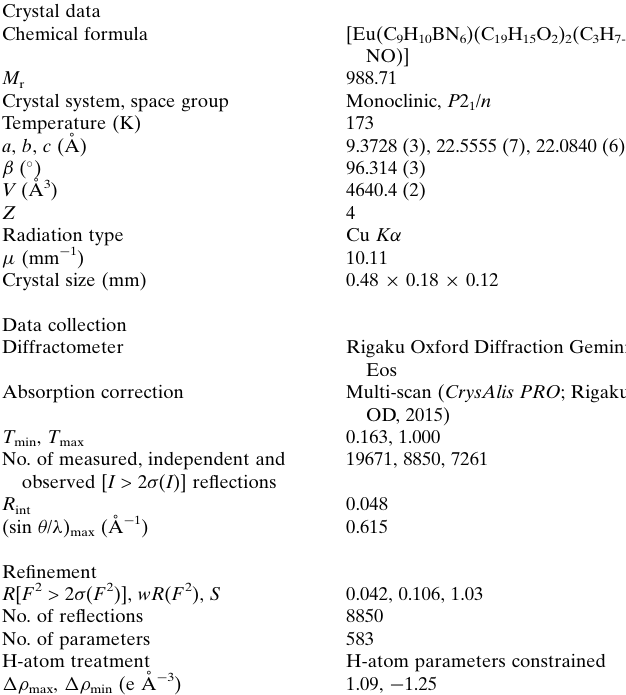
Table 3 Experimental details. Crystal data Chemical